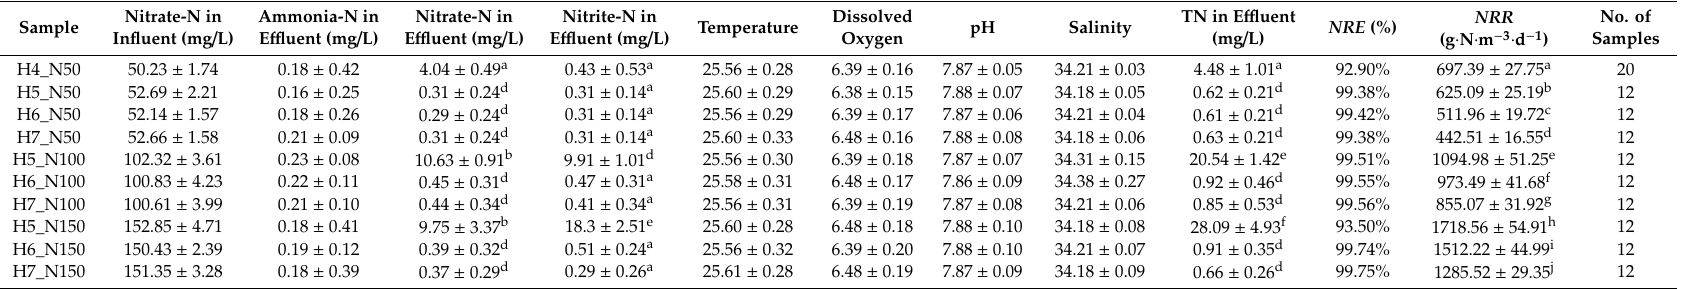
Table 2. Long-term performance of the denitrification process under di ff erent experimental conditions. 1 TN = total nitrogen, NRE = nitrate-N removal e ffi ciency, and NRR = volumetric nitrate-N conversion